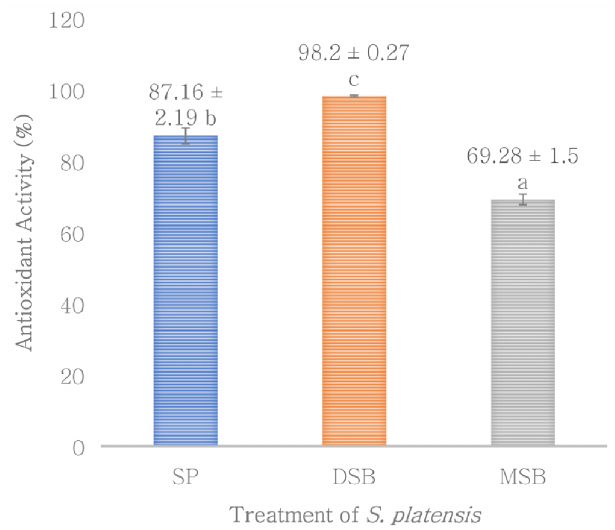
Figure 2. Antioxidant activity (n=3, mean value ± standard deviation; different superscripts indicate a significant difference). SP = S. platensis with no treatment, DSB = S. platensis treated with freeze-dried O. basilicum , MSB = S. platensis treated with microencapsulation freeze-dried O. basilicum .